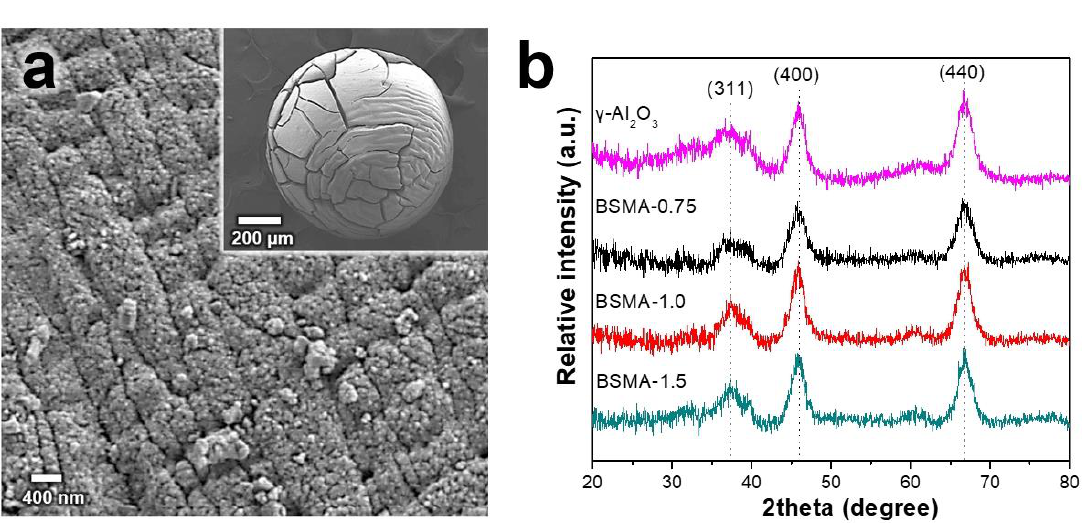
Figure 4. ( a ) SEM image of BSMA-1.5 and ( b ) XRD patterns of commercial γ -Al 2 O 3 and BSMA samples